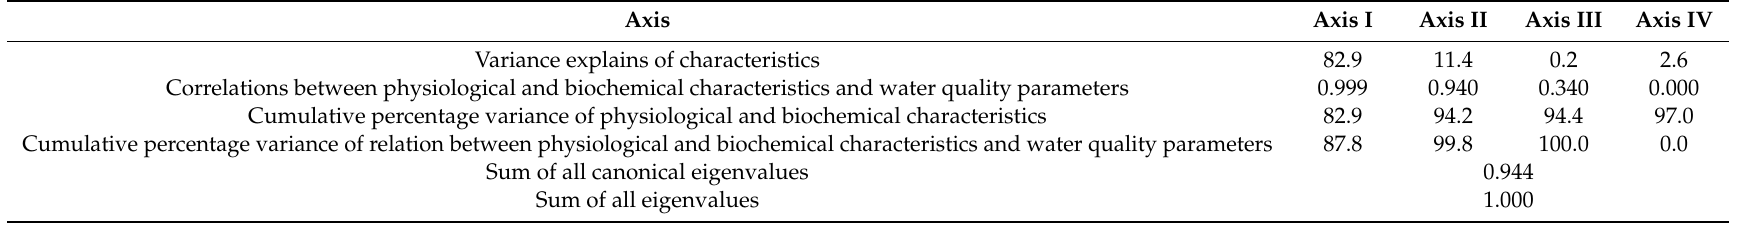
Table 4. The RDA (redundancy analysis) of the physiological and biochemical characteristics of M. spicatum apical